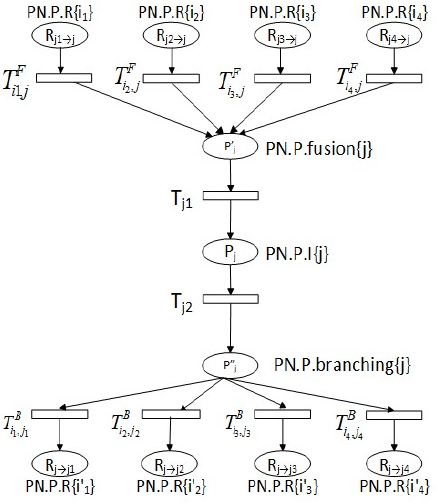
Figure 3. Petri net for a 4-way intersection j.